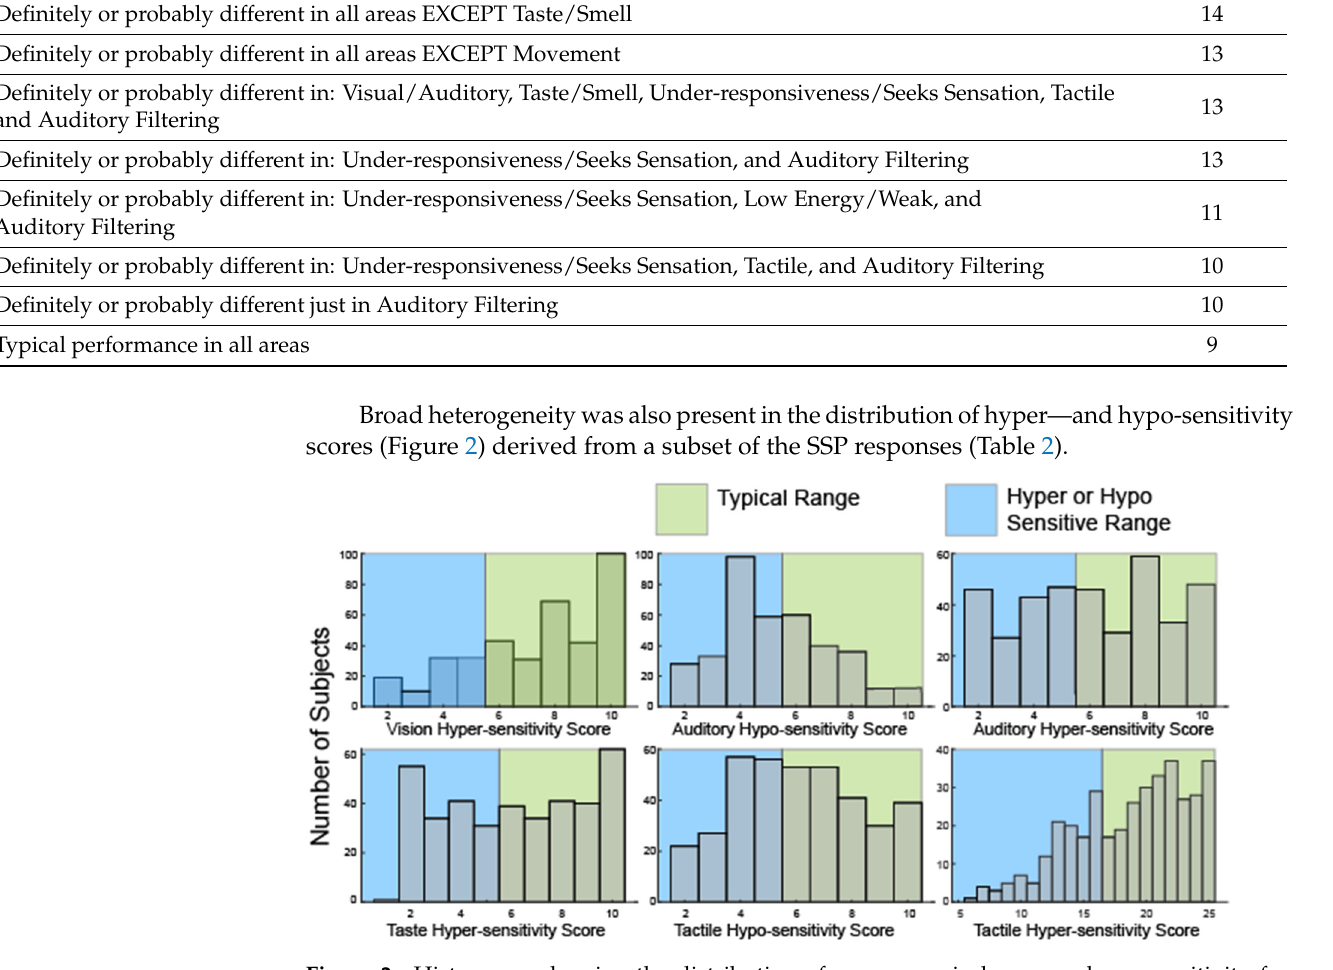
Figure 2. Histograms showing the distribution of raw scores in hyper- or hypo-sensitivity for hearing and touch as well as hyper-sensitivity to vision and taste. No questions in the SSP evaluate hypo-sensitivity to vision or taste or olfactory sensitivities.